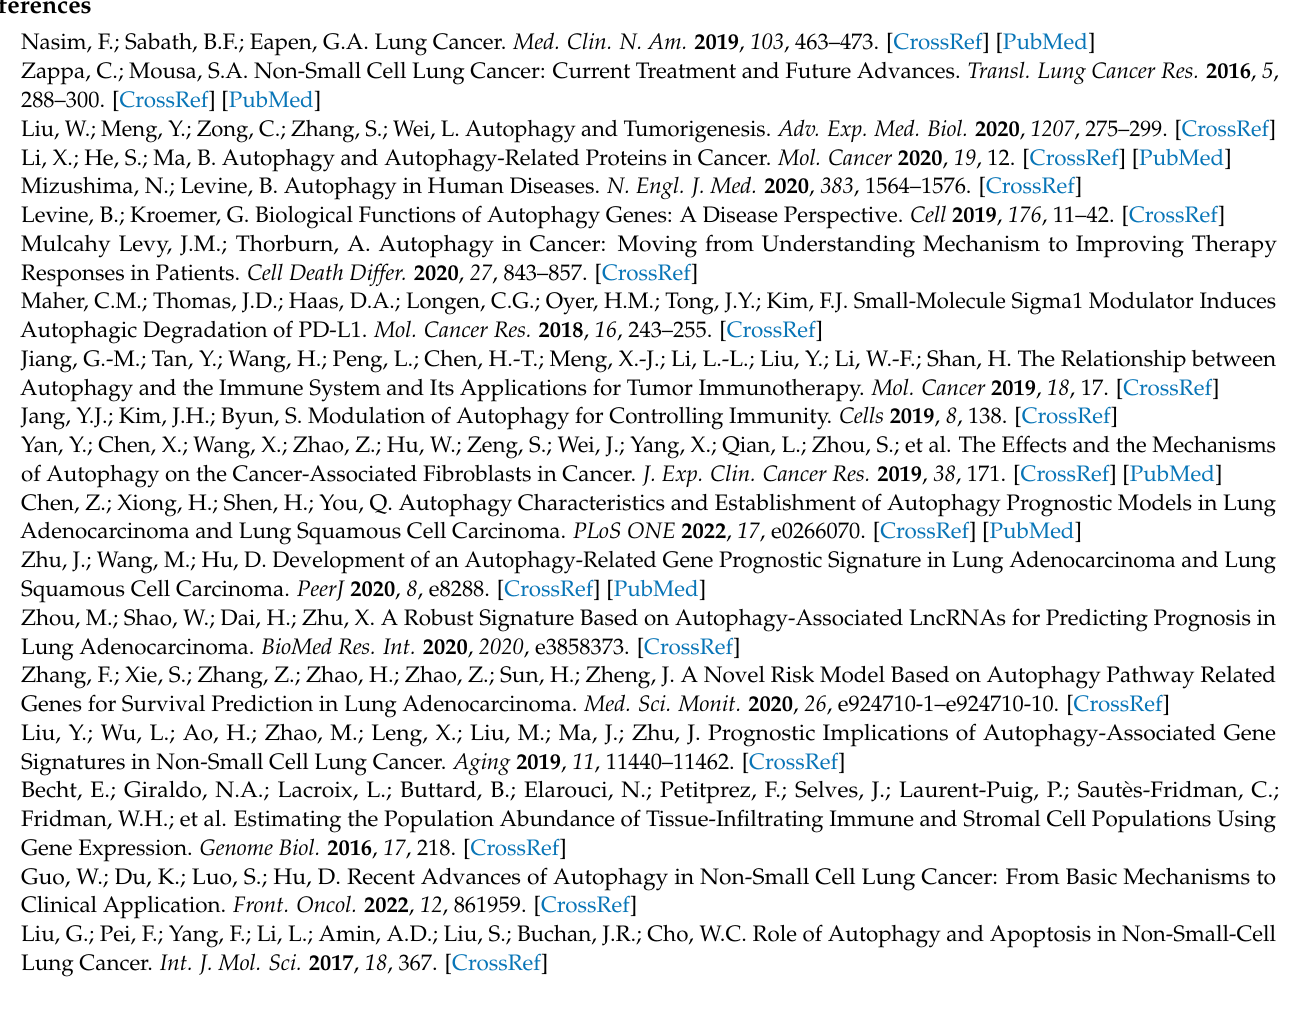
Figure S5: Analysis of autophagy genes expression in tumor cells subtypes. Table S1: Statistical report for Figure S3A. Table S2: Statistical report for Figure 5B. Table S3: Statistical report for Figure 5C. Table S4: Statistical report for Figure S3B. Table S5: Statistical report for Figure